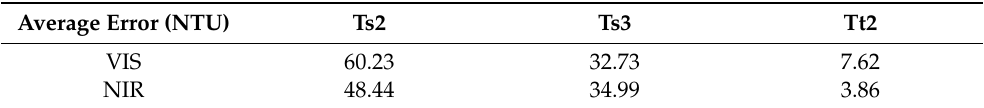
Table 9. Statistics of average error for continuing monitoring of stream water turbidity verified by different lighting sources.